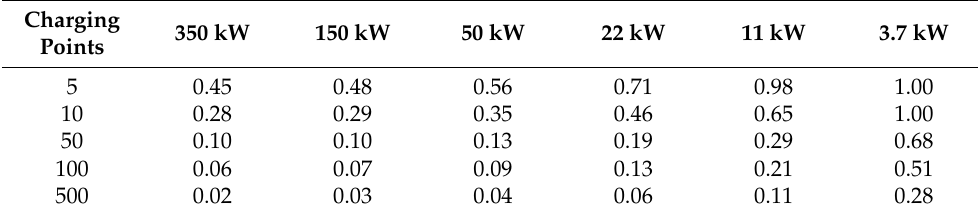
Table A3. Demand factors for the area type “Urban Region: Medium-sized City, Urbanized Area” and six charging powers.